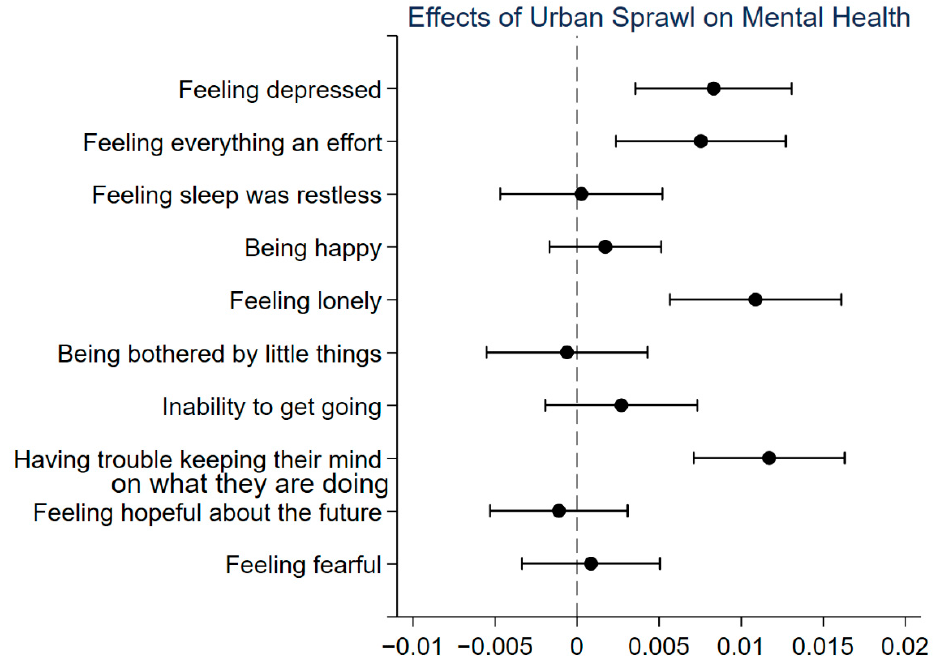
Figure 2. Coefficients and 90% confidence intervals of regressions for each psychological feeling.